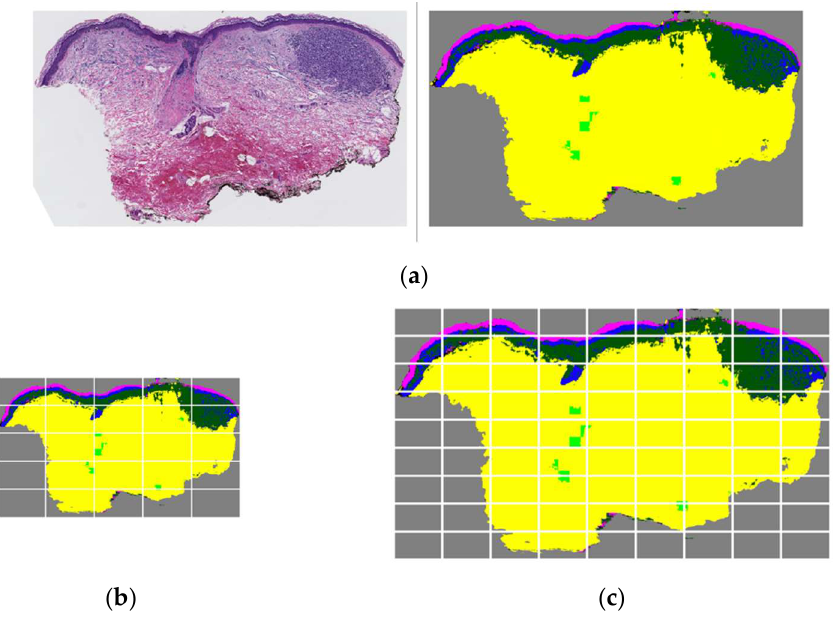
Figure 10. Low-resolution vs. high-resolution patching when there is an inaccurate segmentation mask in the testing case. ( a ) A WSI and corresponding segmentation mask that includes dermis, epidermis, melanoma dermal nest, epidermal nest, corneum, and background. In this example case, epidermal nests are inaccurately segmented and over-labeled. ( b ) The segmentation mask in 7.5 × scale divided into 25 crops as input patches for ScATNet. ( c ) The segmentation mask in 12.5 × scale divided into 81 crops as input patches for ScATNet. There is a higher number of patches with inaccurate and noisy segmentation on the 12.5 × scale compared to the 7.5 × scale, which possibly led to a false prediction on the 12.5 × scale using ScATNet.